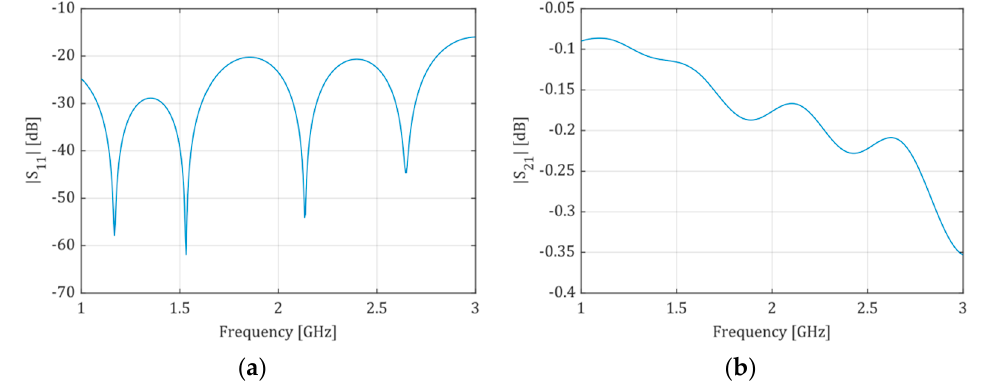
Figure 3. Scattering parameters obtained from simulation of the short-channel LTCC module: